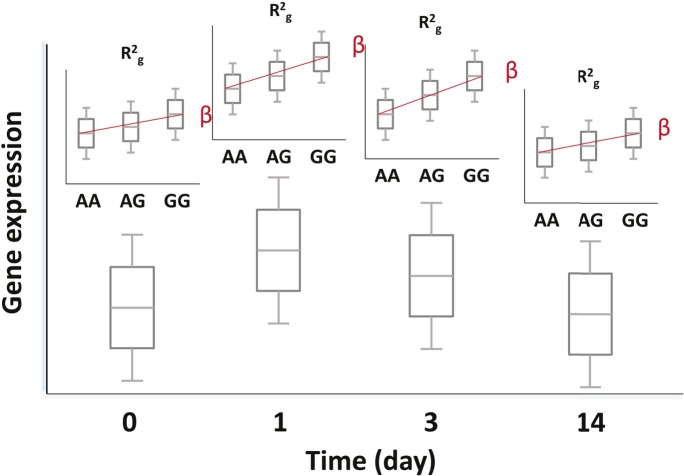
Genetic and transcriptional analysis on a prospective cohort.The figure displays hypothetical results for a single SNP-transcript pair. For any such pair, one may observe changes in transcript abundance at different time points after the experimental perturbation (lower box plots). In addition, gene expression at each time point may be different for different genotypes when there is evidence of an eQTL (upper box plots). Finally, the slope of the expression-genotype association (β), as well as the proportion of the variance in expression explained by genotype (R2g), may vary across time points.